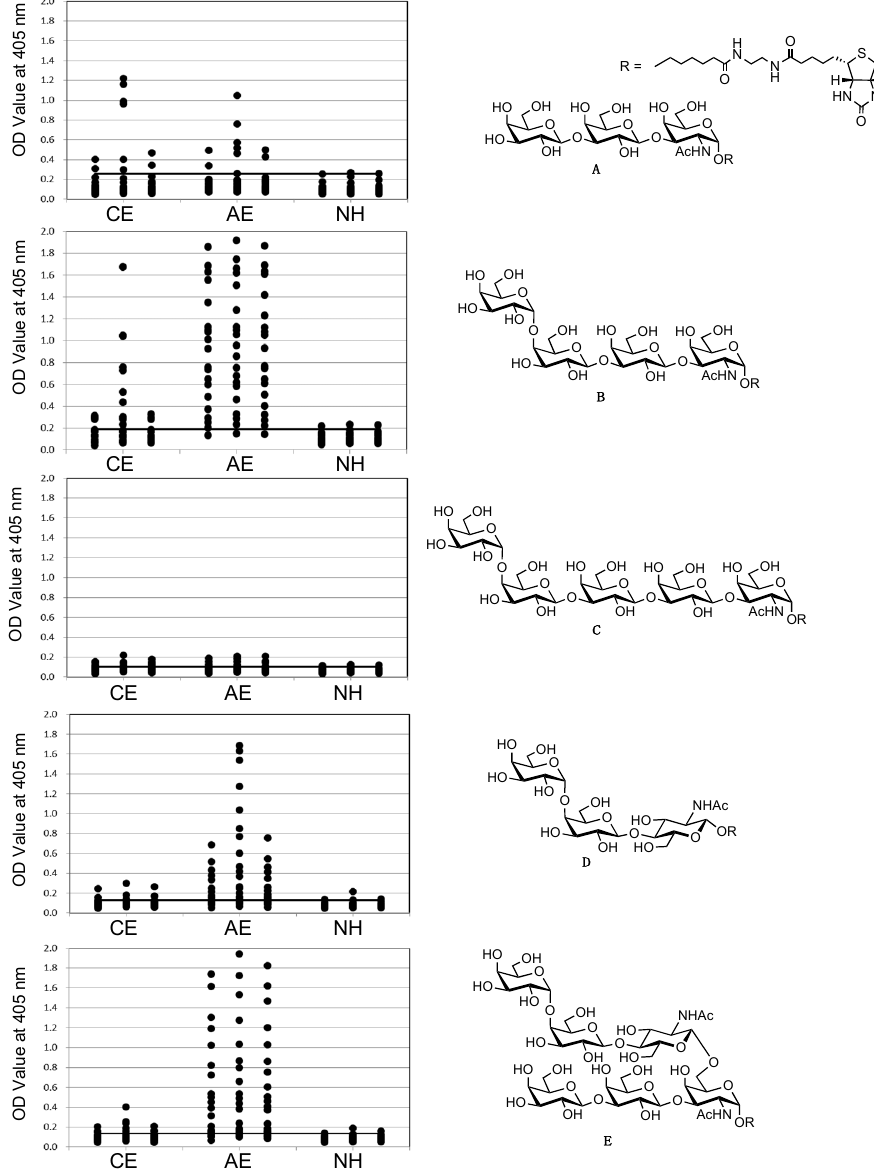
Figure 7. Results of the ELISA reaction between human sera and oligosaccharides A – E . NH: normal healthy group, AE: alveolar echinococcosis positive group, CE: cystic echinococcosis positive group.